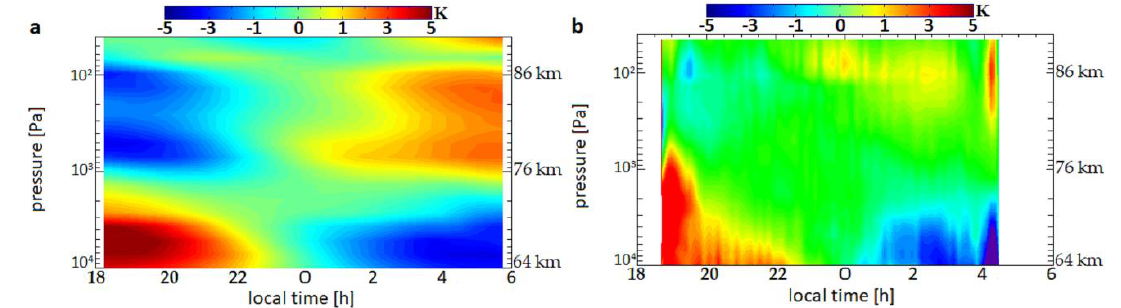
Figure 6. Altitude-local time distribution of the temperature residuals anomalies (K) at –75 ◦ . ( a ) GCM simulation; ( b ) VIRTIS-M observations.